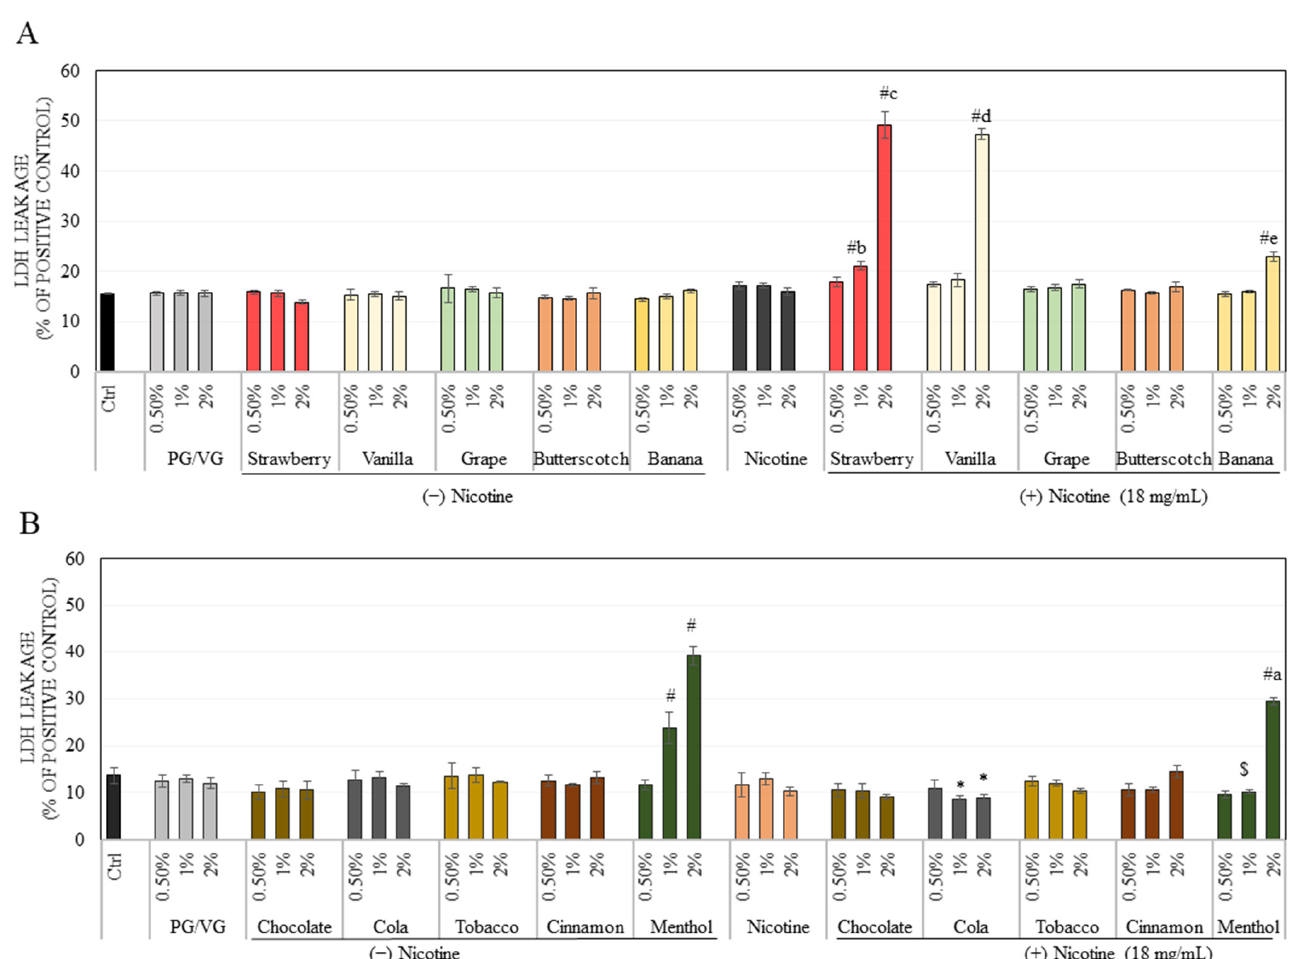
Figure 2. Membrane integrity of ARPE-19 cells after treatment with nicotine-free ( − ) and nicotine-rich (+) e-liquids of ( A ) Flavors: strawberry, vanilla, grape, butterscotch, banana, and ( B ) Flavors: chocolate, cola, tobacco, cinnamon, menthol for a duration of 48 h, as measured by LDH assay. Data are mean ± SD ( n = 3 per group), One-way ANOVA with Tukey’s test. [ * p < 0.05 and # p < 0.0001 vs. Ctrl; b: p < 0.0001 vs. ( − ) strawberry at 1%; c: p < 0.0001 vs. ( − ) strawberry at 2%; d: p < 0.0001 vs. ( − ) vanilla at 2%; e: p < 0.0001 vs. ( − ) banana at 2%; $ p < 0.0001 vs. ( − ) menthol at 1%; a: p < 0.0001 vs. ( − ) menthol at 2%].